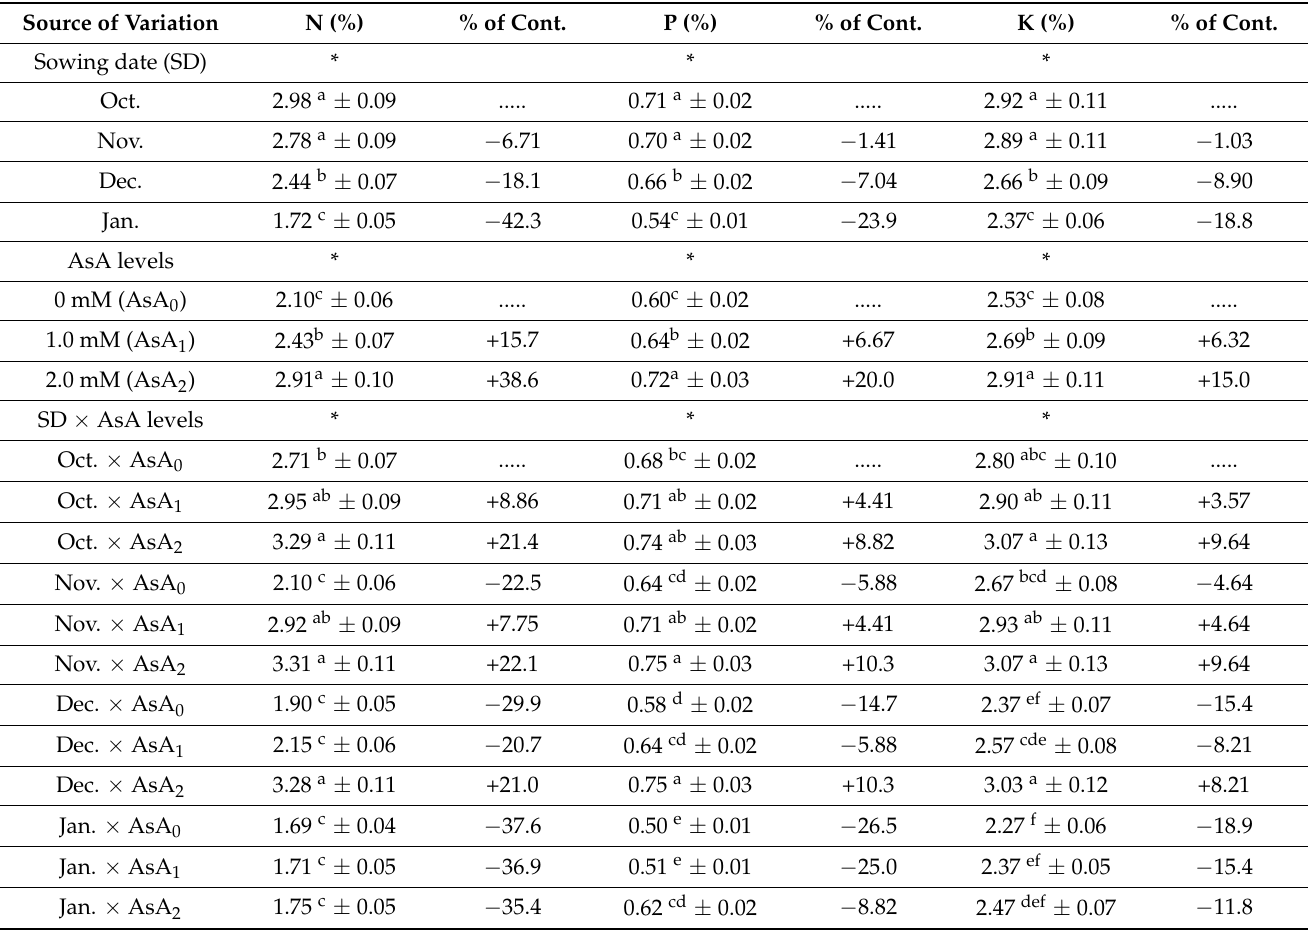
Table 3. Effect of integrative treatment of seeds and leaves with ascorbic acid (AsA) on macronutrient contents of parsley plants under different sowing dates vs. October. All values are the average of the 2018/2019 and 2019/2020 seasons.